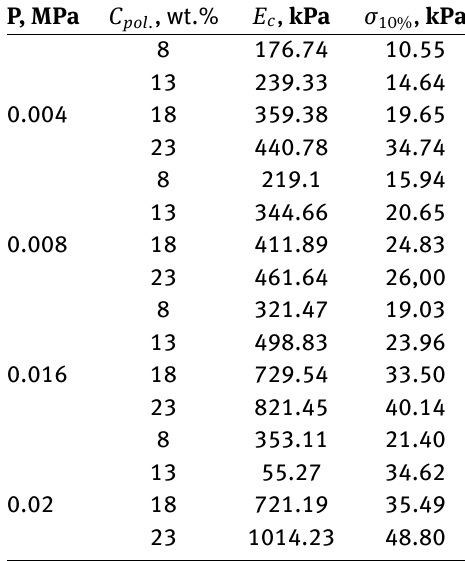
Table 1: Variation in compressive modulus of elasticity ( E c ) and compressive stress at 10% deformation ( σ 10% ) with molding pres- sure (P) and polymer binder content ( C pol ).